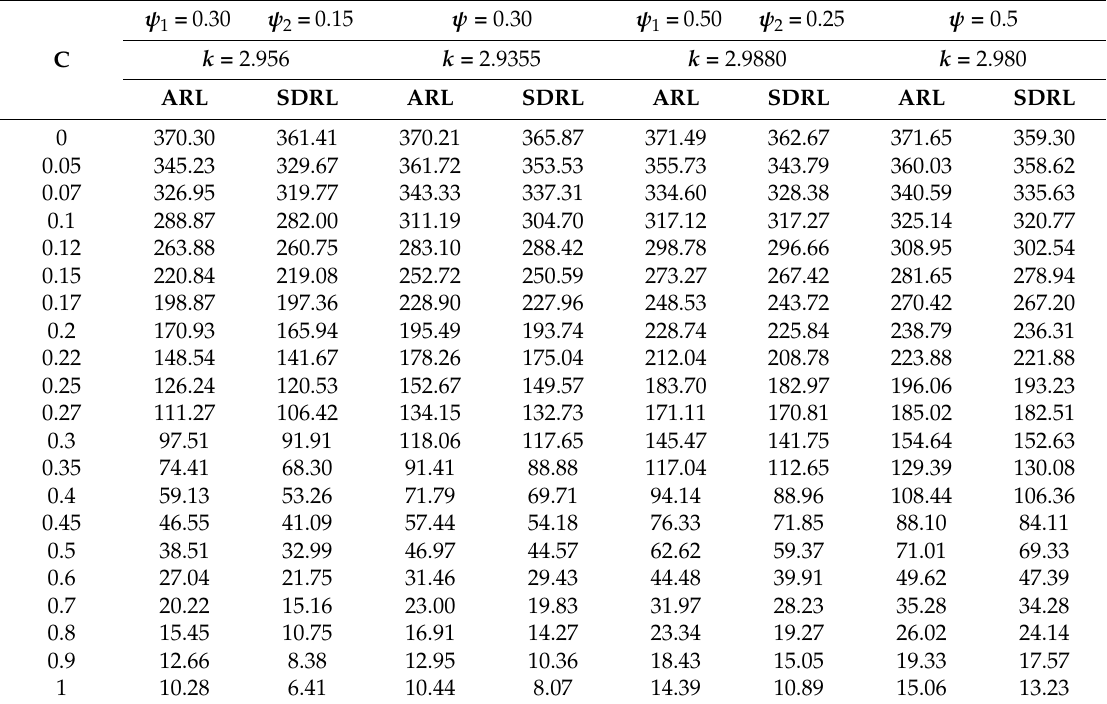
Table 4. The ARL, SDRL values of the proposed EEWMA and EWMA control charts for various shifts when r 0 = 370.